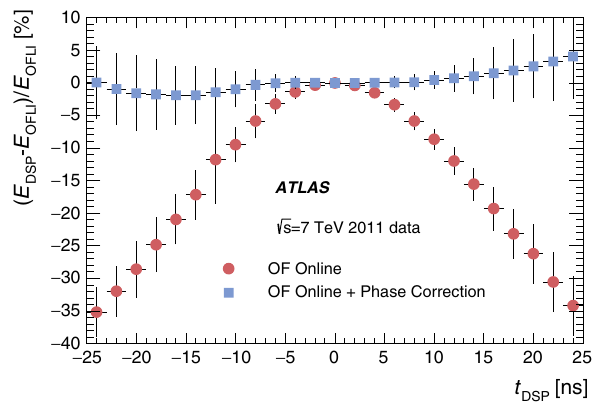
Fig. 3 The relative difference between the online channel energy ( E DSP ) calculated using the non-iterative OF method and the offline ( E OFLI ) channel energy reconstruction using the iterative OF method, asafunctionofthephasecomputedbytheDSP( t DSP )withnocorrection (circles) and with application of the parabolic correction (squares) as a function of phase ( τ ). The error bars are the standard deviations (RMS) of the relative difference distribution. Data are shown for collisions in 2011 pointarithmetic,whichhasaprecisionof0.0625ADCcounts